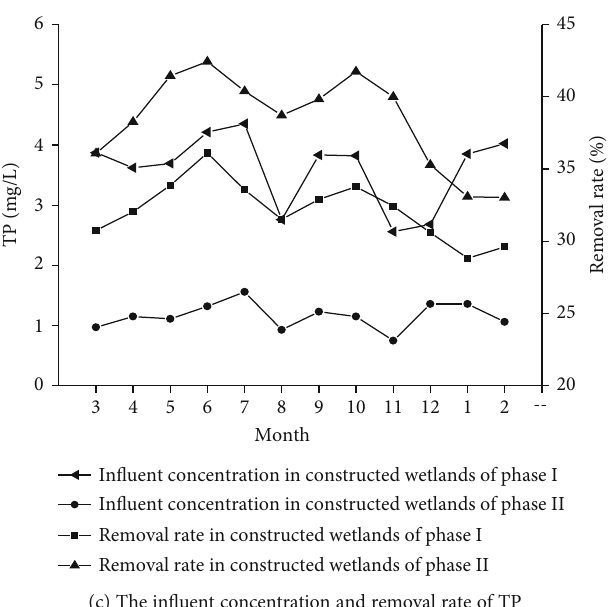
Figure 5: In fl uent concentration and removal rate of constructed